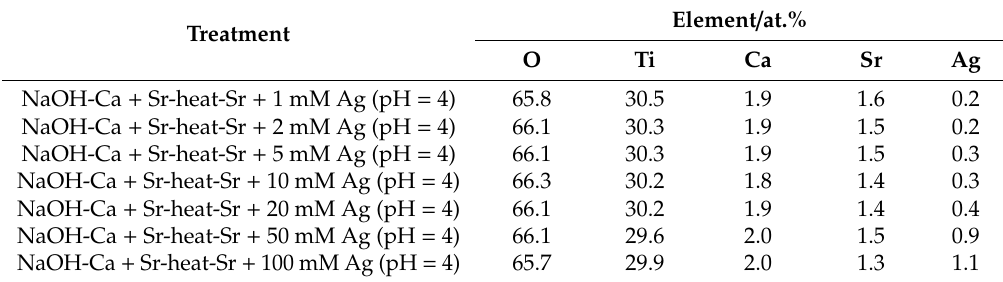
Table 3. The results of EDX analysis on the surface of Ti subjected to Sr + X mM Ag (pH = 4) treatment ( X = 1–100) following NaOH, Ca + Sr and heat treatment.